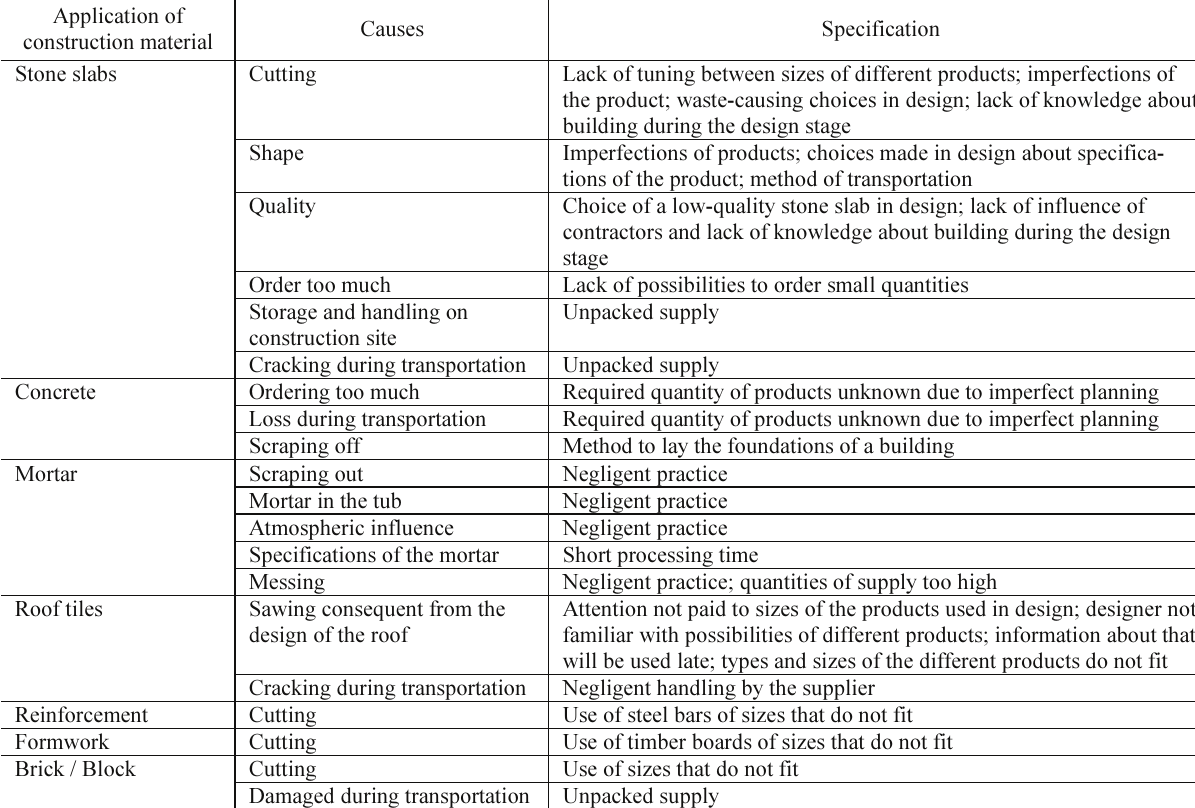
Table 1. Causes of material wastage (Shen et al. 2002) Application